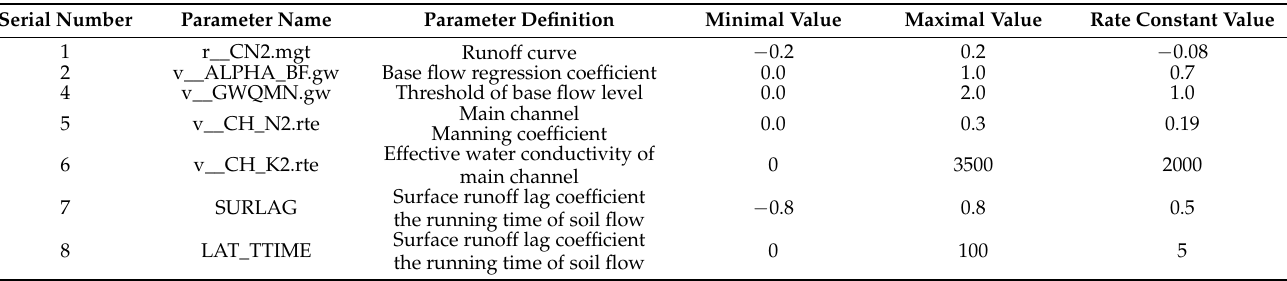
Table 4. Selection and setting of sensitivity parameters.